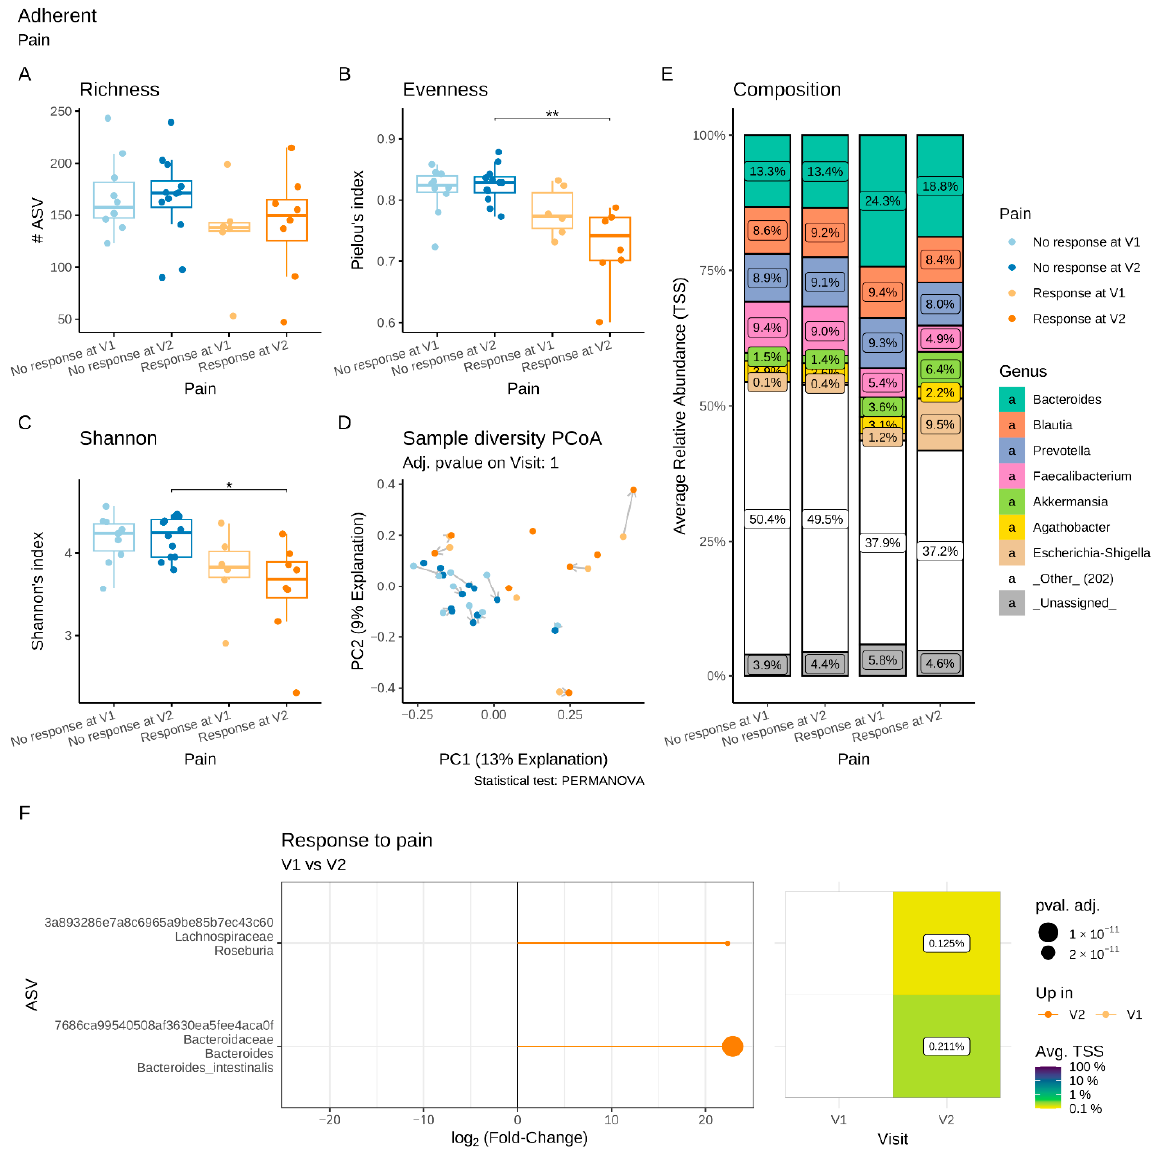
Figure 6. Impact of a 4-week supplementation with the multistrain probiotic on the adherent gut microbiota in Pain responders (R) and non-responders (NR). ( A – C ): α -diversity, estimated by the richness (number of observed ASVs) ( A ), evenness (Pielou’s index) ( B ) and Shannon’s index ( C ); ( D ) principal coordinate analysis (PCoA) of bacterial β -diversity, measured according to the Bray– Curtis distance; ( E ) bacterial taxonomic profile at genus level before (V1) and after (V2) supplementa- tion; ( F ) differential abundance analysis at the ASV level at V1 and V2 in Pain R. Only significant data are presented as Log2 of the fold of change (FC) according to DESeq2 analysis. *: p < 0.05, **: p < 0.01 Transcription start sites (TSS)